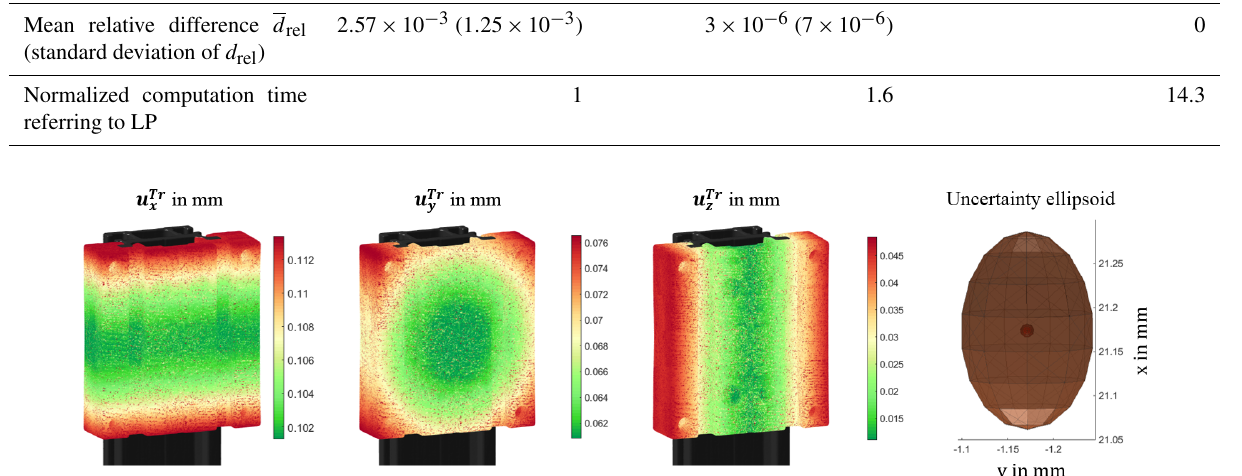
Figure 4. Uncertainty components u Tr x , u Tr y , and u Tr z of the x , y , and z components, respectively (from left to right), and uncertainty ellipsoid for U Pt (small red sphere) and U Tr (large brown ellipsoid) around an arbitrarily selected point.